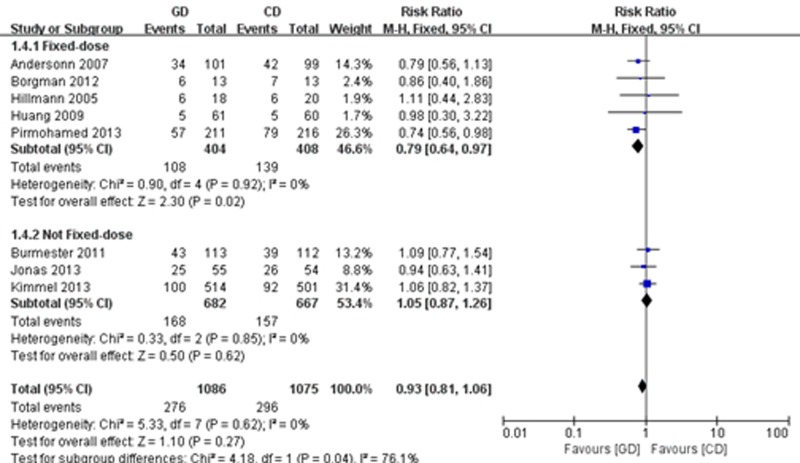
Forest plot of an INR greater than 4.